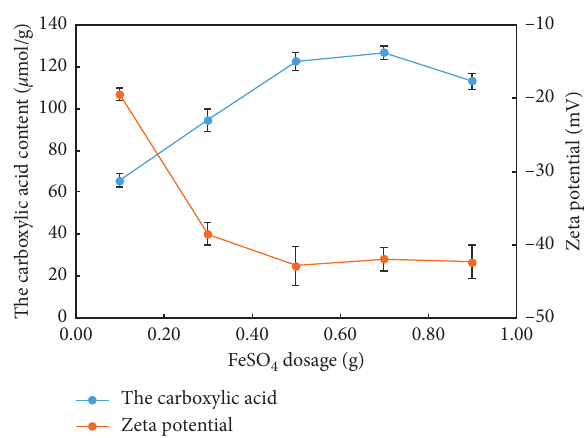
Figure 1: The effect of FeSO